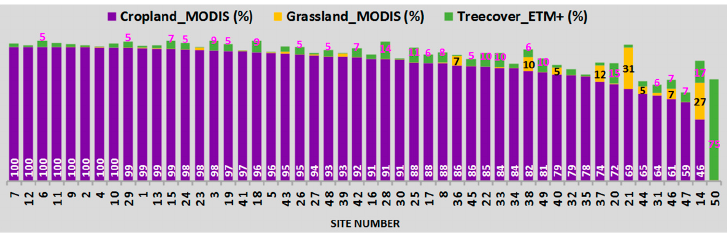
Figure 2. Average cropland (purple), and grassland (orange) cover in percent for 2003–2010 from the MODIS IGBP Land Cover Type 1 Percent Product at ~5.6 km spatial resolution MCD12C1 [27], and tree cover fraction (%) in 2010 from the Landsat ETM+ 30 m resolution Global Land Cover product [33]. X-axis indicates study sites numbered from lower (1) to higher (50) latitudes. Figure 1 shows the latitudinal distributions of the study sites and countries in which they are found. Sites are sorted from largest (left) to smallest (right) cropland cover percent. Site 50 is a Mixed Forest site, in Mari El, RU. Note that summation of land cover proportions can exceed 100% at some sites, because the tree cover data source is different and at a different scale from the other two land cover classes. Cropland cover in some sites might be larger than what is presented here, since the MODIS land cover data has a separate class named Cropland/Natural Vegetation Mosaic (CNVM, IGBP class 14), which is not illustrated here to avoid overlap with the tree cover data. Land cover values >5% are labeled on the respective bars. These MODIS land cover data are also used in [22].